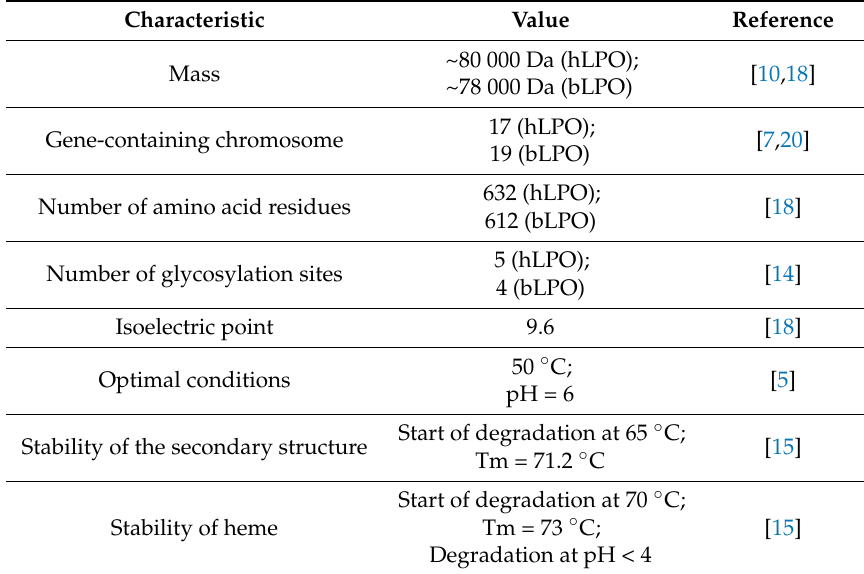
Table 1. Structure and physiochemical properties of human and bovine lactoperoxidase.